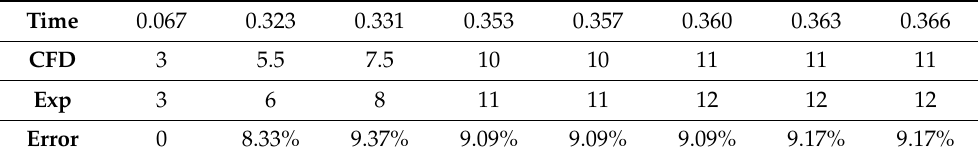
Table 2. Comparison of bubble width in experiment and CFD.